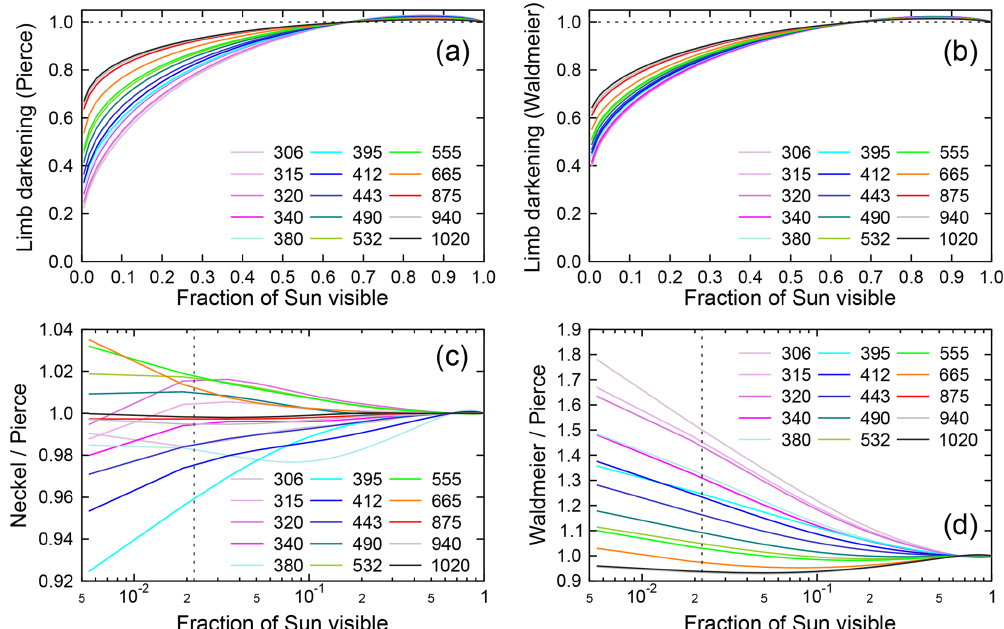
Figure 7. Comparison of the solar LD effect calculated with the parameterizations by Pierce, Neckel, and Waldmeier. (a, b) Ratios of the extraterrestrial solar spectral irradiance during the eclipse to the spectral irradiance from a hypothetical Sun without LD, plotted versus the fraction of the Sun that is visible. (a) and (b) are based on the parameterizations by Pierce and Waldmeier, respectively. (c, d) Ratios of LD effect calculated by the parameterizations by Neckel and Pierce (c) and by Waldmeier and Pierce (d) . The vertical broken line indicates the minimum fraction of 0.022 (2.2% of the Sun’s disk) that could be assessed with our